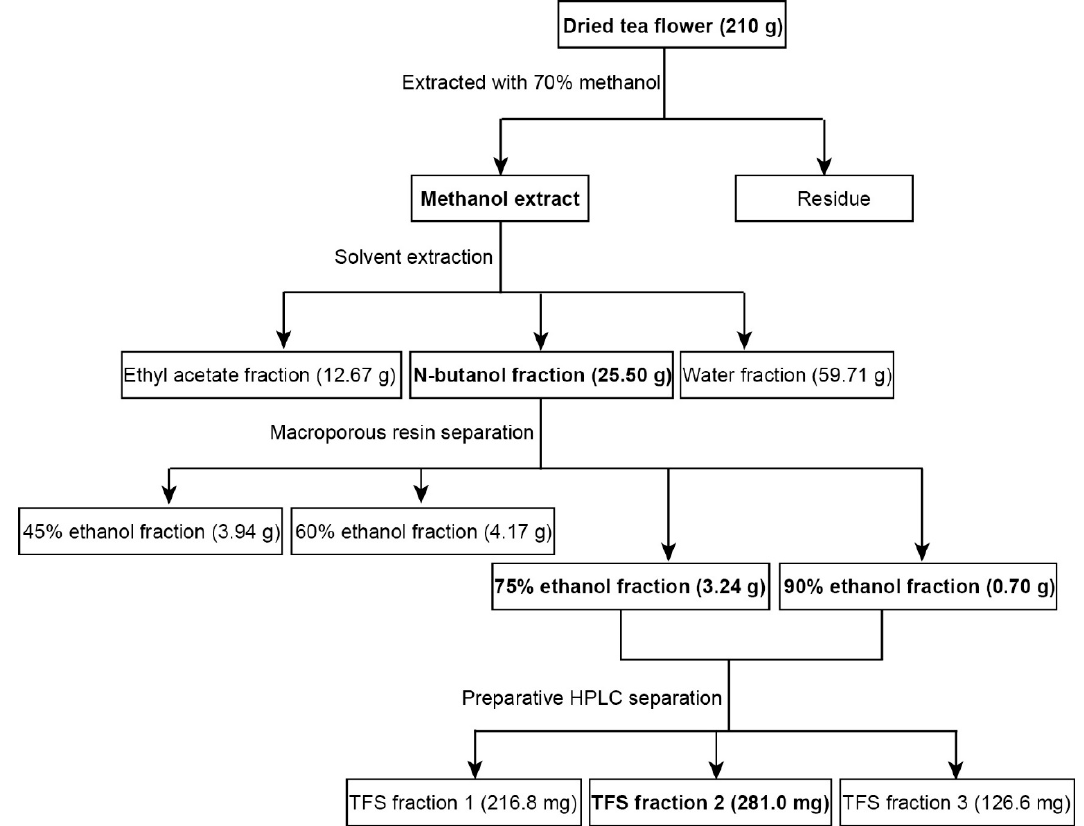
Figure 1. Extraction and isolation scheme of tea flower saponins (TFS) from tea flowers.